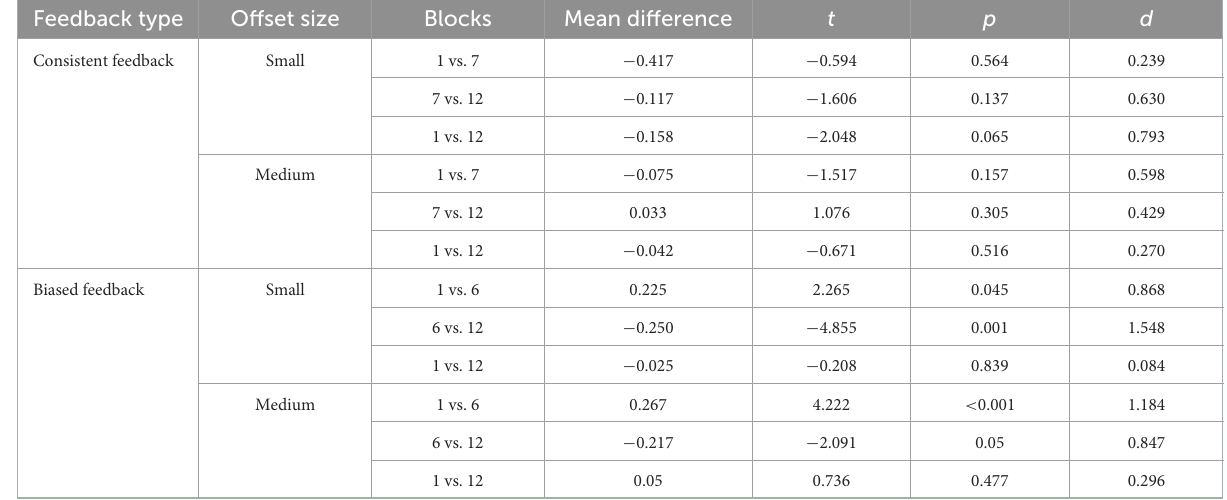
TABLE 1 T -tests of trial